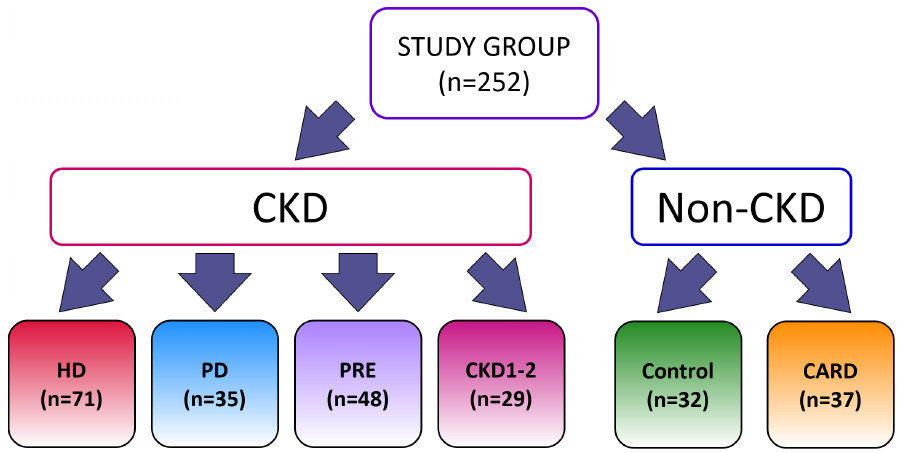
Figure 1. Division into groups selected for this